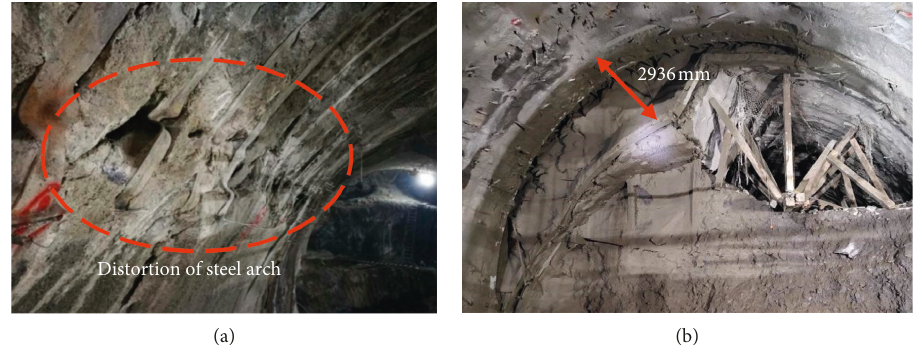
Figure 5: Deformation and failure characteristics of primary lining. (a) Distortion of steel arch. (b) Large deformation of the surrounding rock.